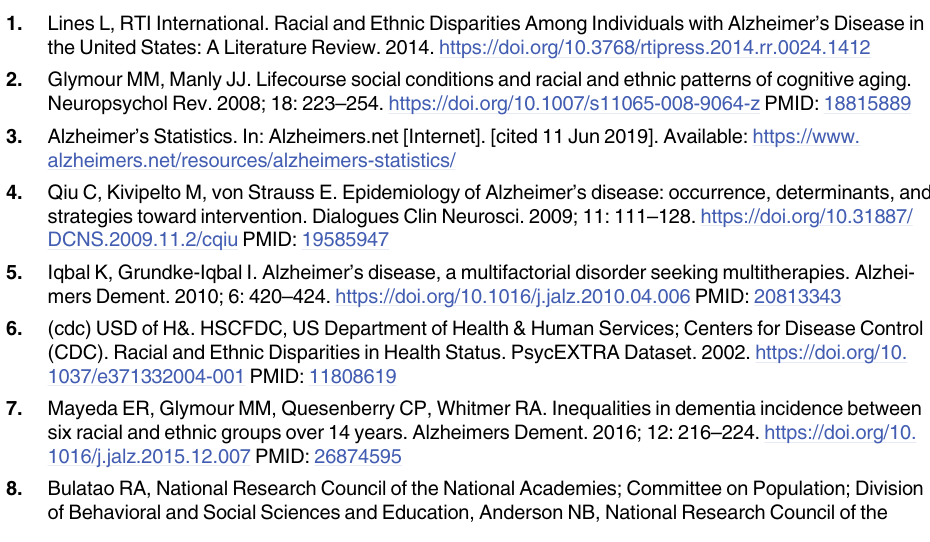
S1 Table. Selected known comorbidities that we controlled to build a balanced cohort. S2 Table. Causal structure of African Americans and Caucasian counterparts. S3 Table. Definition of late effect of cerebrovascular disease and transient cerebral